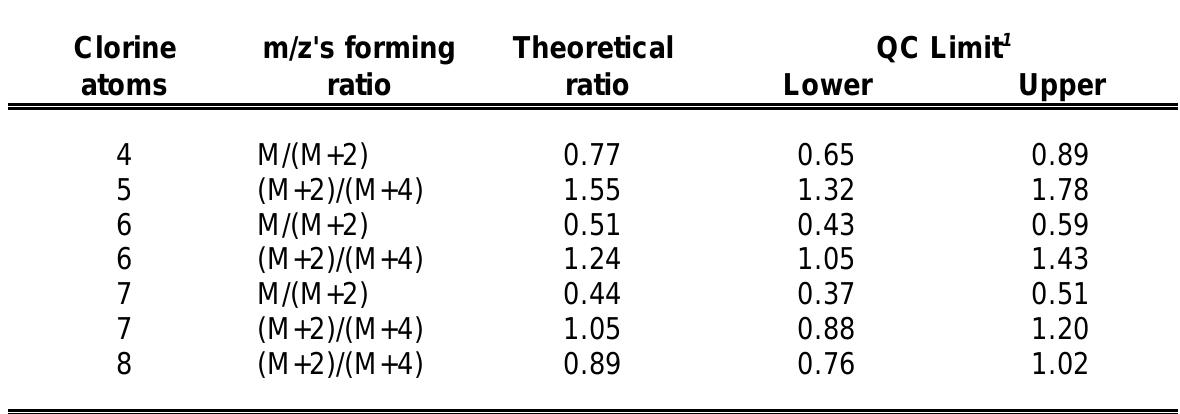
Table 9. Theoretical Ion Abundance Ratios and QC